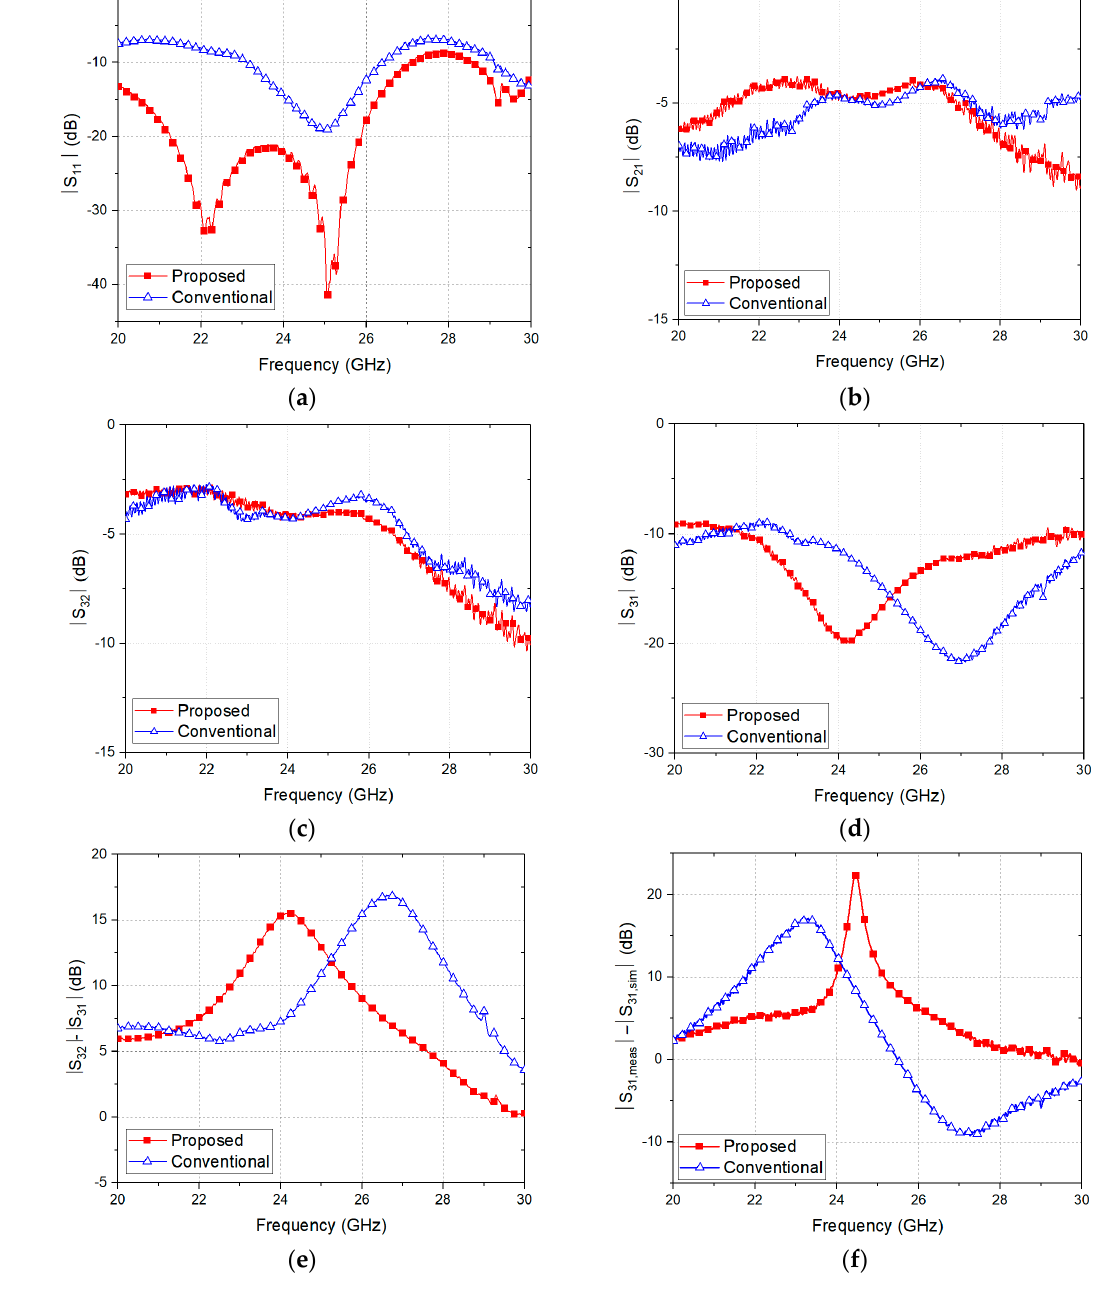
Figure 9. Measured S -parameters of the proposed and conventional quasi-circulators at 24.125 GHz: ( a ) | S 11 |; ( b ) | S 21 |; ( c ) | S 32 |; ( d ) | S 31 |; ( e ) | S 32 | − | S 31 |; ( f ) the difference of |S 31 | between the simulation and the measurement. Table 1. Comparisons of the proposed quasi-circulators and the conventional quasi-circulators.